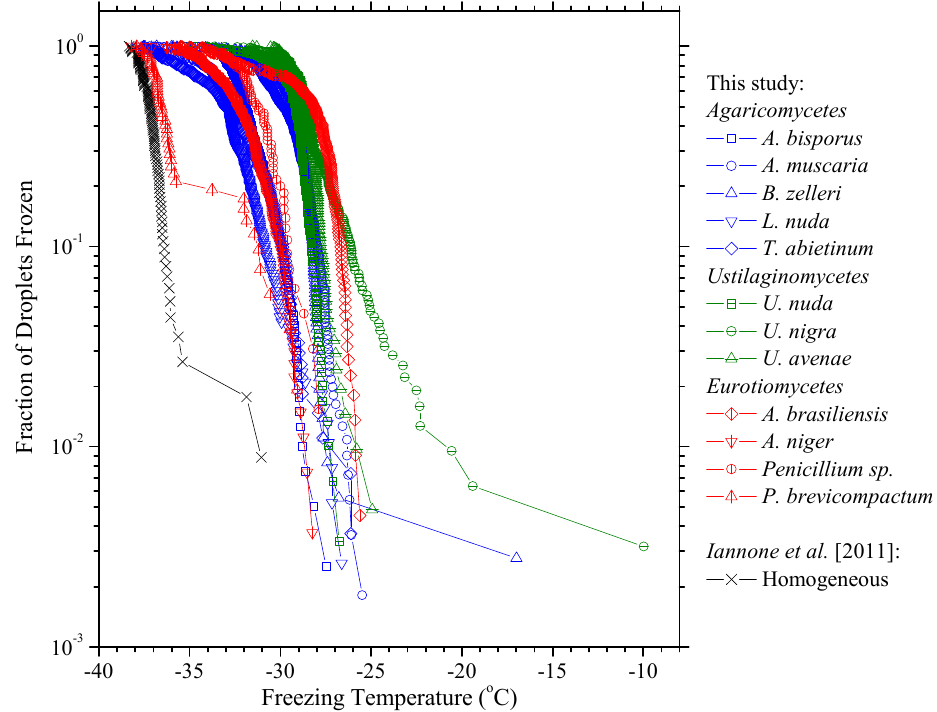
Figure 2. Fraction of droplets frozen as a function of temperature. Agaricomycetes spores ( A. bisporus , A. muscaria , B. zelleri , L. nuda , and T. abietinum ) are in blue (open symbols); Ustilaginomycetes spores ( U. nuda , U. nigra , and U. avenae ) are in green (open symbols with a horizontal line); Eurotiomycetes spores ( A. brasiliensis , A. niger , Penicillium sp., and P. brevicompactum ) are in red (open symbols with a vertical line). Homogeneous freezing results (×) (Iannone et al., 2011), obtained using the same apparatus as this study, are also